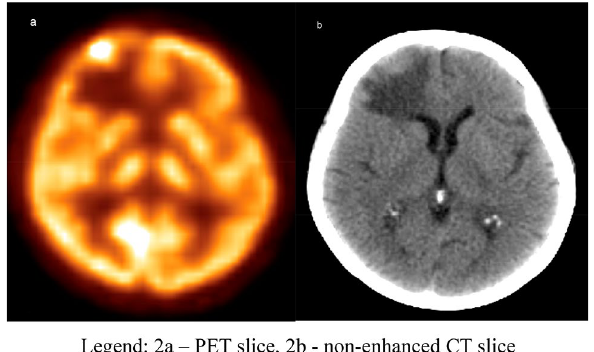
Figure 2. 46 y.o. patient with ovarian cancer scanned with the [18F]FDG PET/CT before surgery. Abnormal finding within the right frontal lobe showing a lesion with increased [18F]FDG uptake surrounded by brain